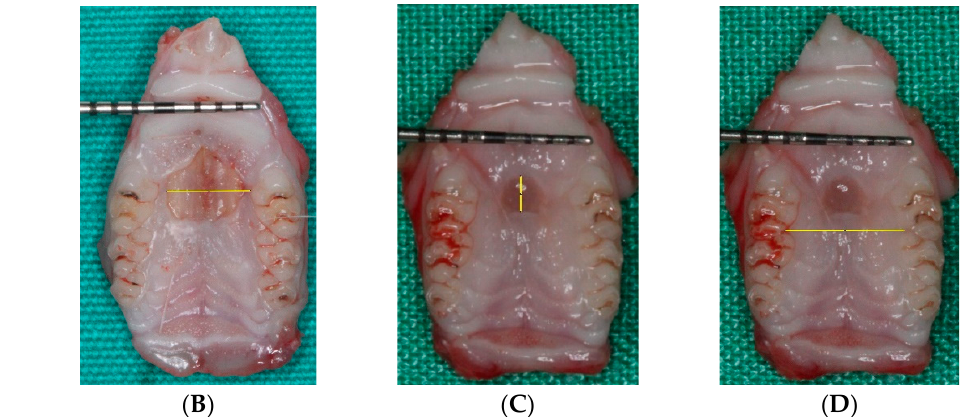
Figure 1. Representative photographs of the wounds using a 1 mm periodontal probe as scale measurement . ( A ) Total area in mm 2 of the wound at one week. ( B ) Maximum L-L length in mm of the wound at two weeks. ( C ) Maximum A-P length in mm of the wound at three weeks. ( D ) Palatal width in mm (Arch distance) at three weeks.